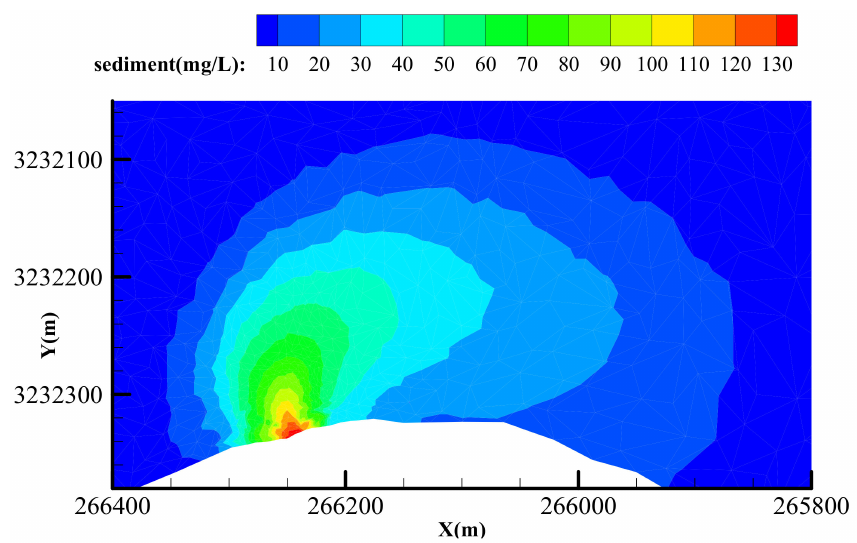
Figure 9. Sediment distribution by sand-laden discharge in an area near the